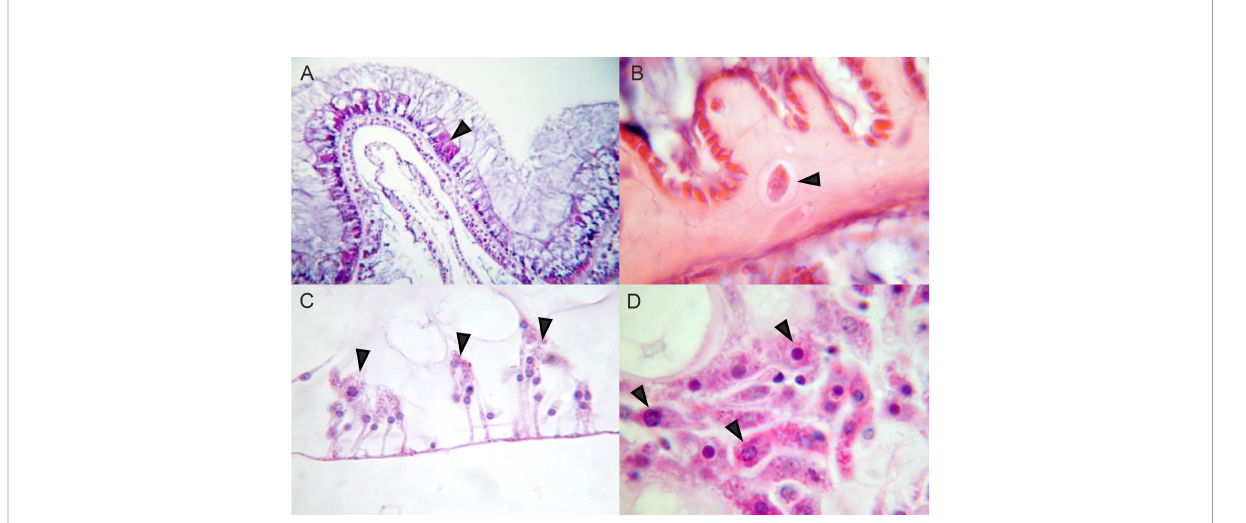
FIGURE 2 Amoebocytes in Hexacorals and Octocorals (A) Scleractinian hexacoral Orbicella faveolata , arrowhead indicates eosinophilic granular amoebocytes in surface epithelium. (B) Scleractinian hexacoral Pseudodiploria strigosa , arrowhead indicates amoebocyte transiting through mesoglea. (C) Octocoral Plexaurella fusifera , arrowheads indicate eosinophilic granular cells on surface. (D) Octocoral sea fan Gorgonia ventalina , arrowheads indicate eosinophilic granular amoebocytes in